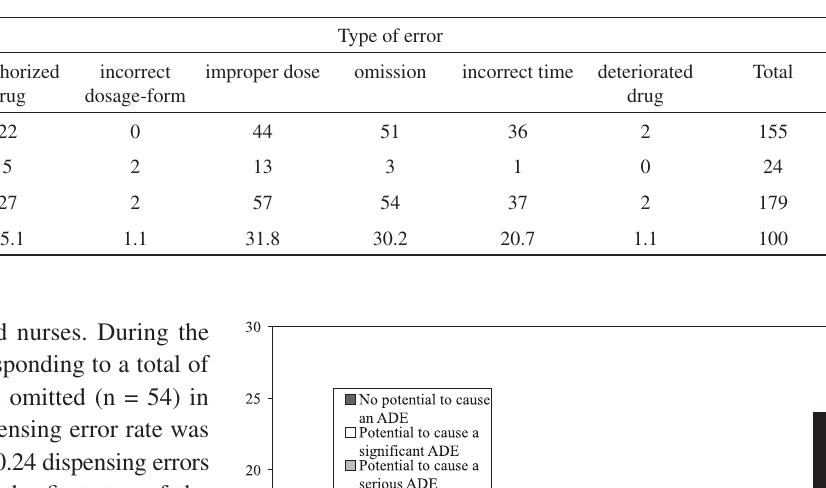
Table 1 - Types of medication-dispensing errors detected by pharmacists and nurses